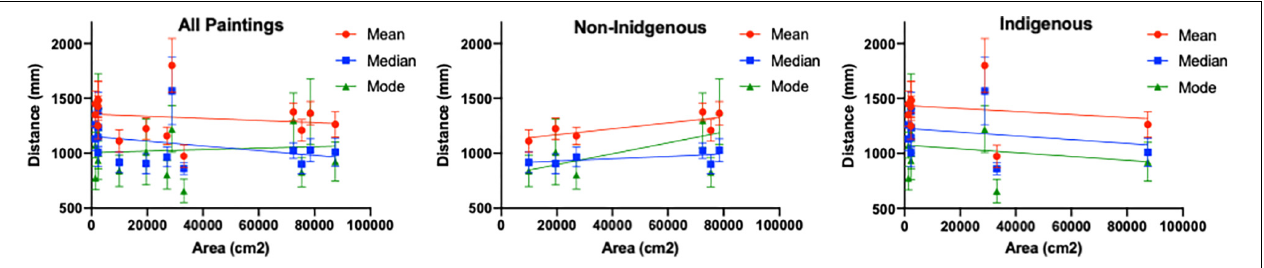
FIGURE 6 | The average mean, median and mode viewing distance as a function of painting area. The error bars represent SEM.